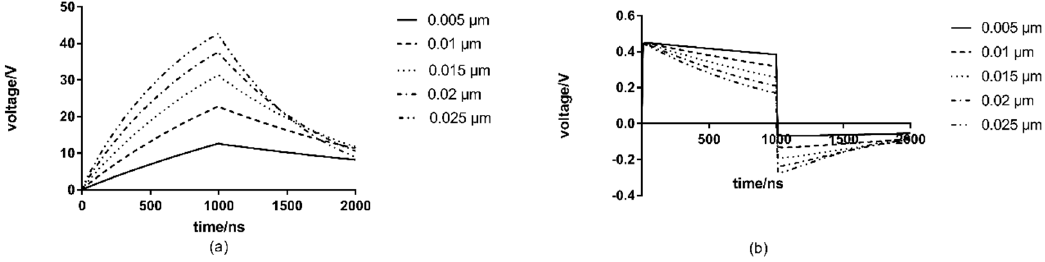
Figure 4. Effect of membrane thickness on transmembrane voltage: ( a ) cell membrane transmembrane voltage ( b ) nuclear membrane transmembrane voltage.